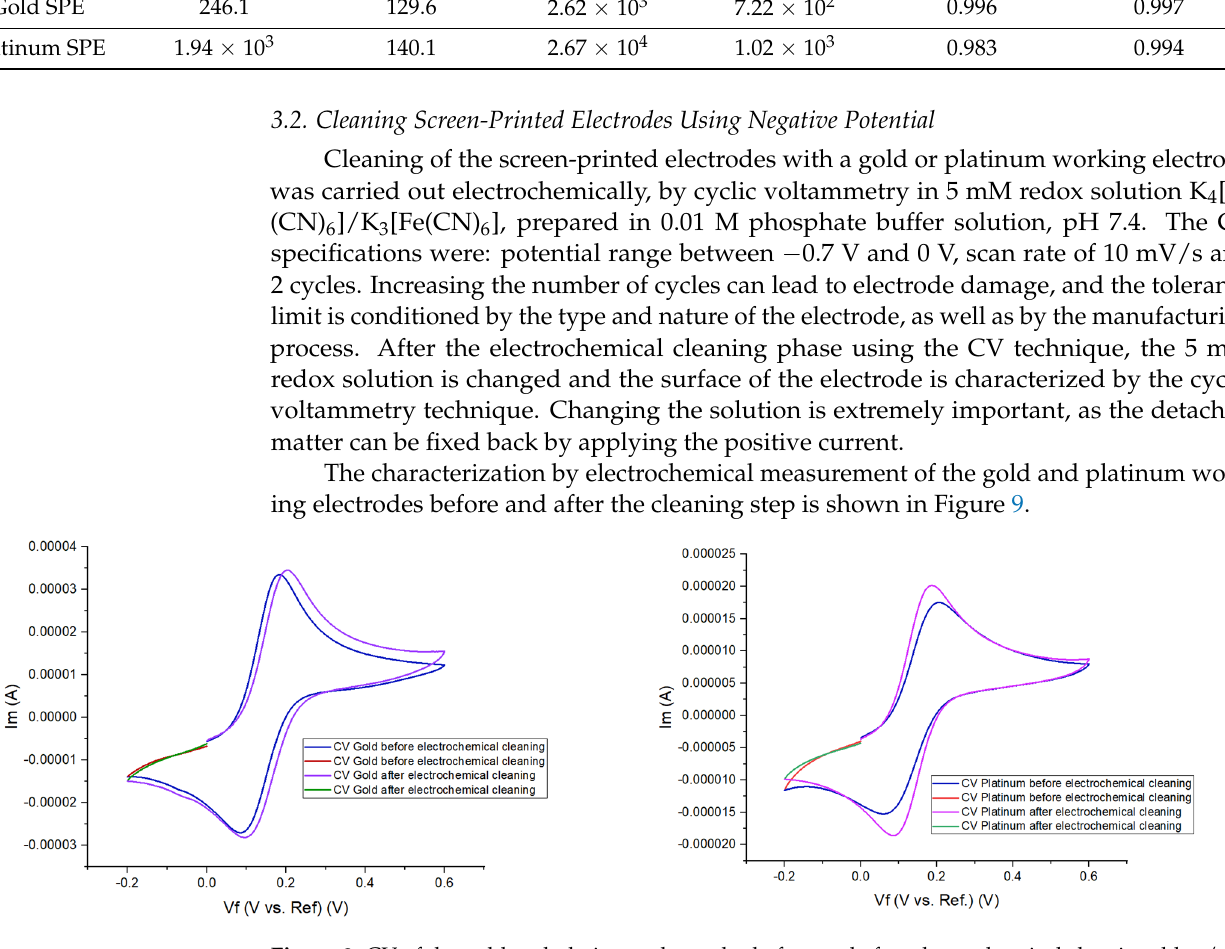
Table 6. EIS measurements before and after H 2 O 2 cleaning.